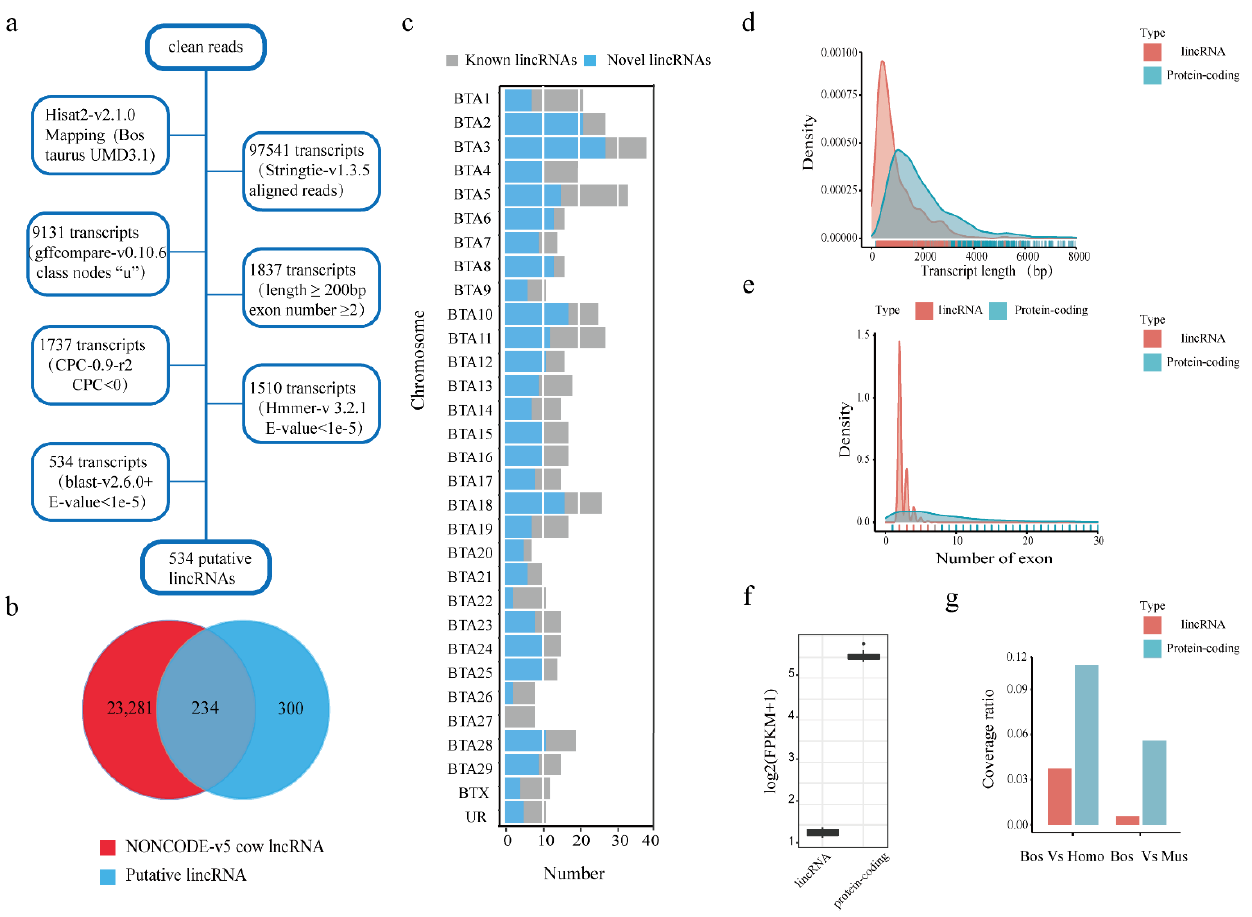
Figure 1. Identification and characterization analysis of the putative long intergenic non-coding RNAs (lincRNAs). ( a ) Pipeline for the identification of putative lincRNAs. ( b ) Venn diagram of known and novel lincRNAs. ( c ) Bos taurus chromosome distribution of putative lincRNAs. Blue: novel lincRNAs, gray: known lincRNAs. (UR: unknown region, included NKLS02001272.1, NKLS02002063.1, NKLS02002207.1, NKLS02002210.1, NKLS02001064.1, NKLS02001662.1, NKLS02002183.1). ( d ) Transcript length of putative lincRNAs and protein-coding gene (X axis represent the range of transcription length (bp); Y axis represent the portion of specific length of transcripts); ( e ) exon numbers of lincRNAs and protein-coding gene (X axis represent the range of exon number; Y axis represent the portion of specific number of exon); ( f ) the expression levels of lincRNAs and protein-coding gene; ( g ) evolutionary conservation between protein-coding genes and putative lincRNAs of Bos taurus (Bos) with Homo sapiens (Homo) and Mus musculus (Mus) .